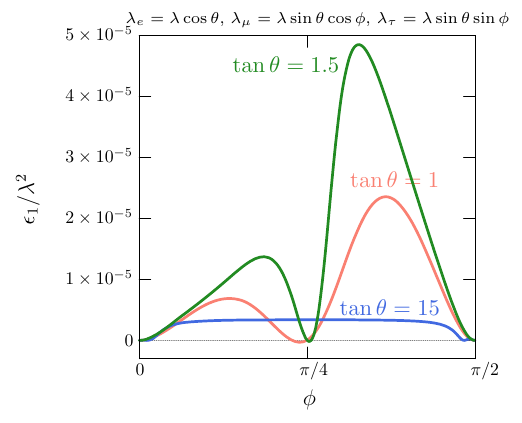
Fig. 5 The asymmetry parameter (cid:13) 1 /λ 2 as a function of the diagonal neutrino Yukawa couplings, which are parametrized as ,λ μ ,λ τ ) = λ( cos θ, sin θ cos φ, sin θ sin φ) . The input oscillation (λ e parameters (θ 12 ,θ 23 ,θ 13 ,δ m 2 ,(cid:6) m 2 ) are taken to be their best-fit val- uesinTable1,whilethesignoftheDiracphase δ istakentobenegative, δ < 0 (or δ > π